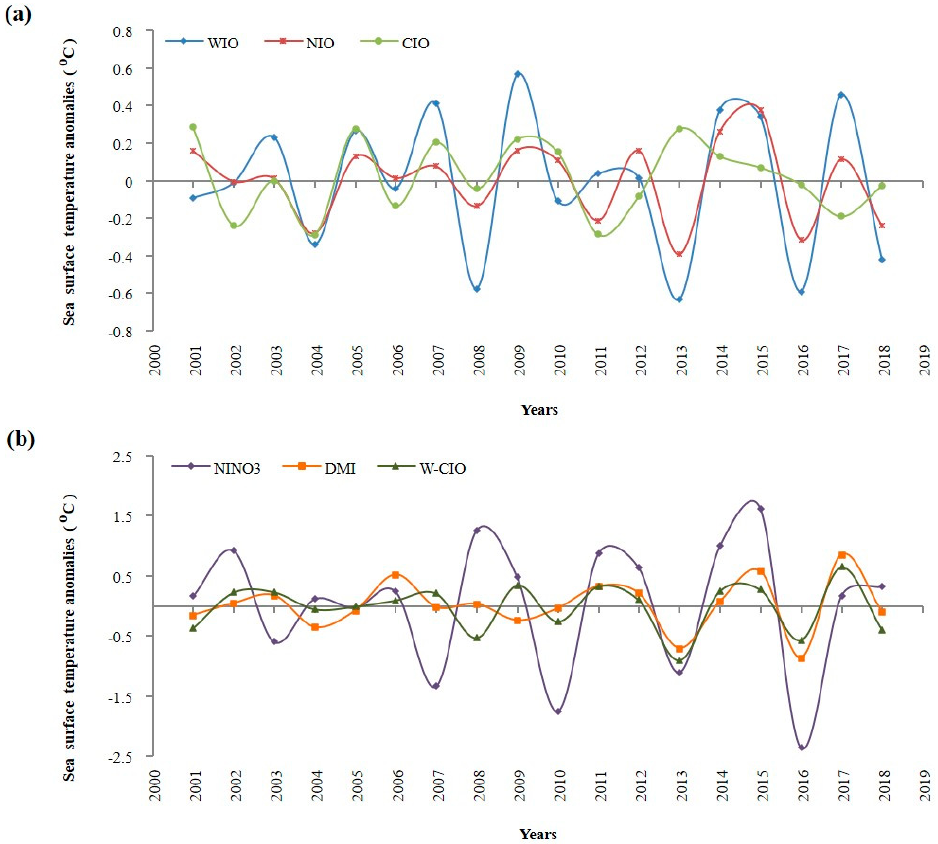
Figure 4. Time series of basin-wise average SST anomalies over ( a ) Western Indian Ocean, North Indian Ocean and Central Indian Ocean and time series of ( b ) NINO3 SST anomalies, DMI and W-CIO index during monsoon season (2001–2018), which depicts a strong interannual variability. (Software used: Python version 3.7 (2019), https://www.python.org/ (accessed on 12 September 2021) and R version 4.0.5 (2021), https://www.R-project.org/ (accessed on 12 September 2021)). Table 4. The correlation coefficients (r) between SST and SIF during the months of June, July, August and September as mentioned across the Western, Northern and Central Indian Ocean. The correlation coefficients (r) shown in bold text are statistically significant at 95% CI.